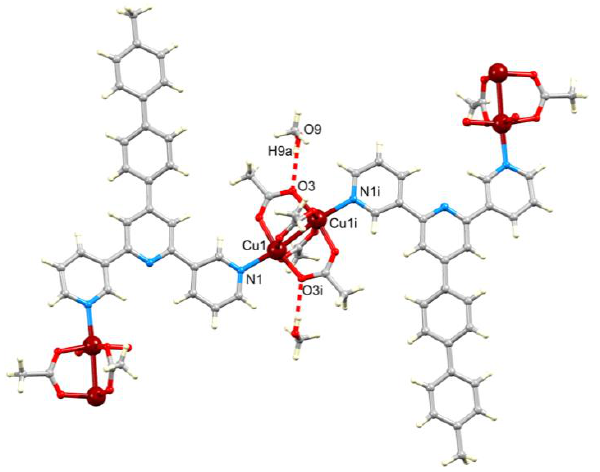
Figure 5. Hydrogen-bonded MeOH molecule in [Cu 2 ( µ -OAc) 4 ( 5 )] n · n MeOH, which resides in a